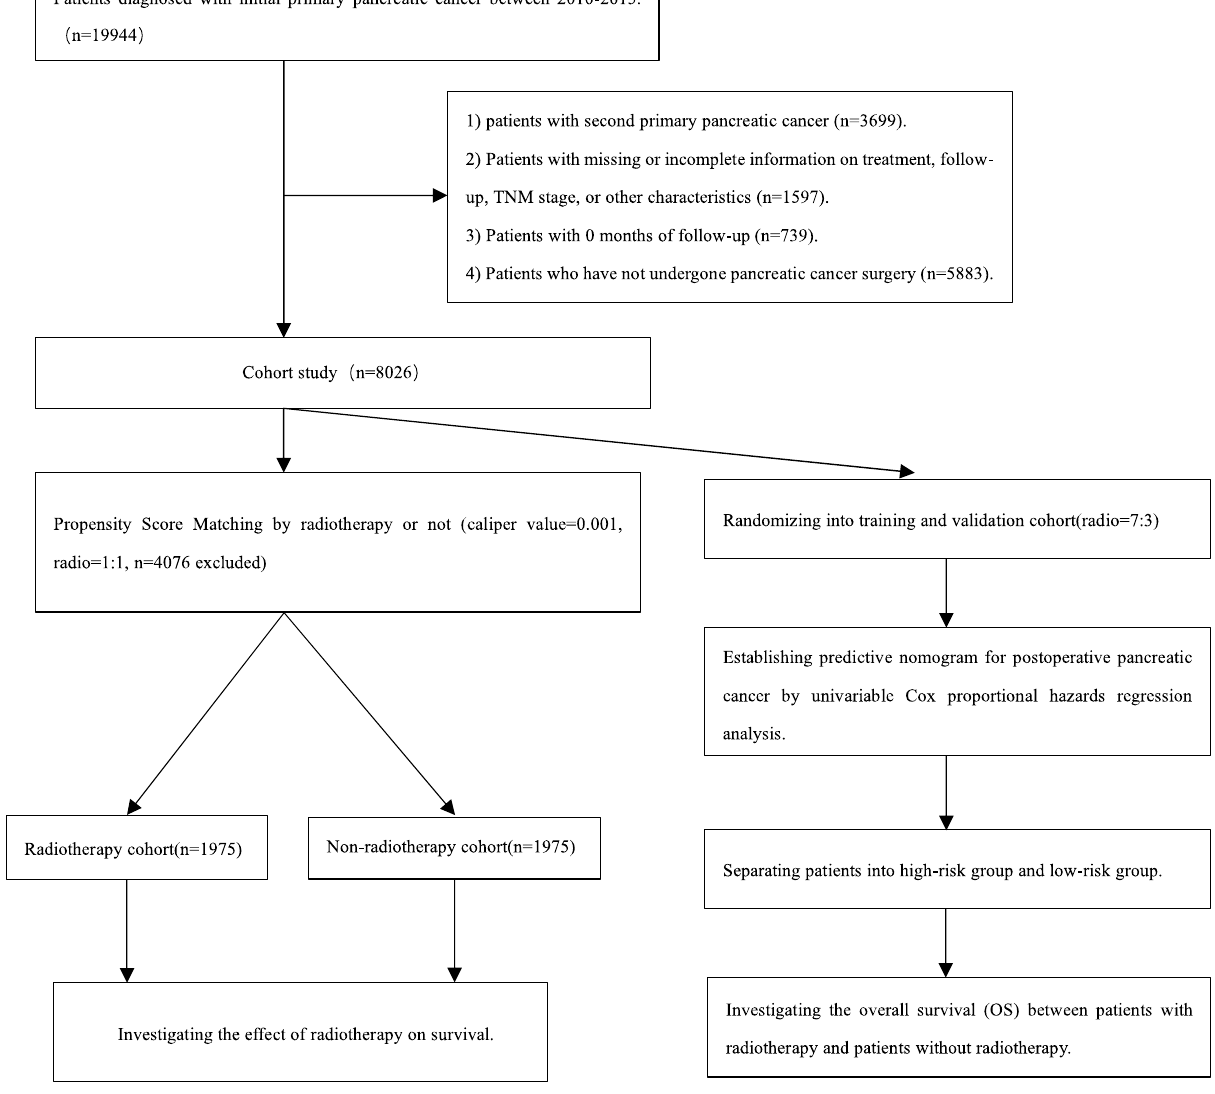
Figure 1. The data selection steps of the present